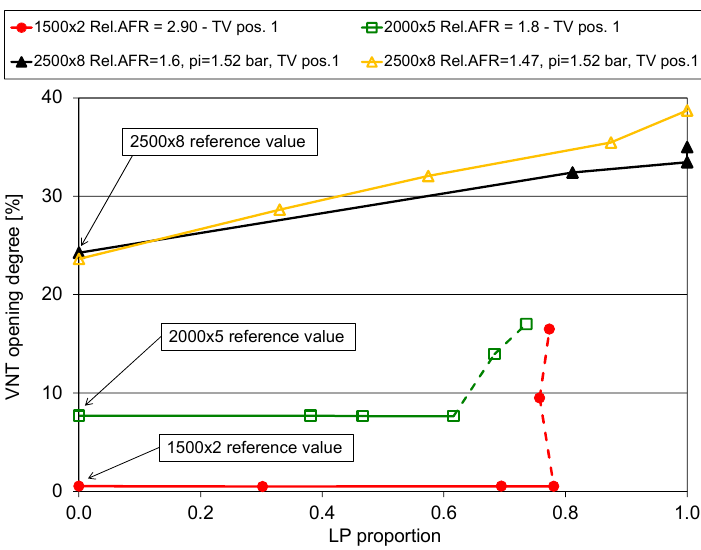
Figure 10. VNT opening degree as a function of LP proportion in different operating modes.